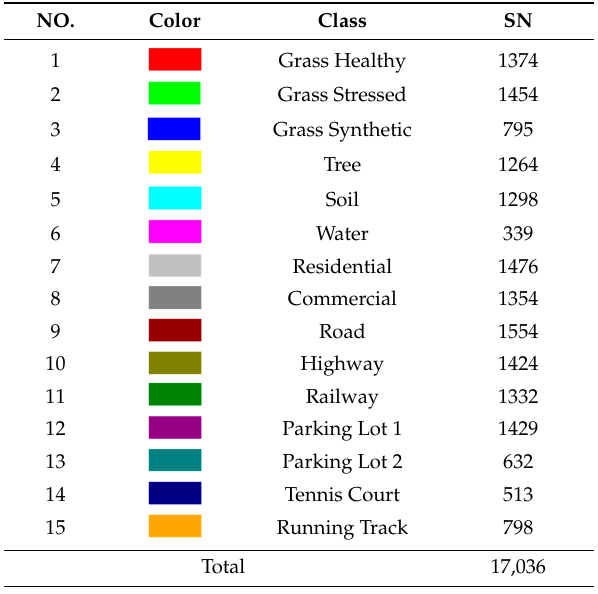
Table 3. Color codes for the classes, class types, and sample numbers (SN) for the ground truth of the Houston data.